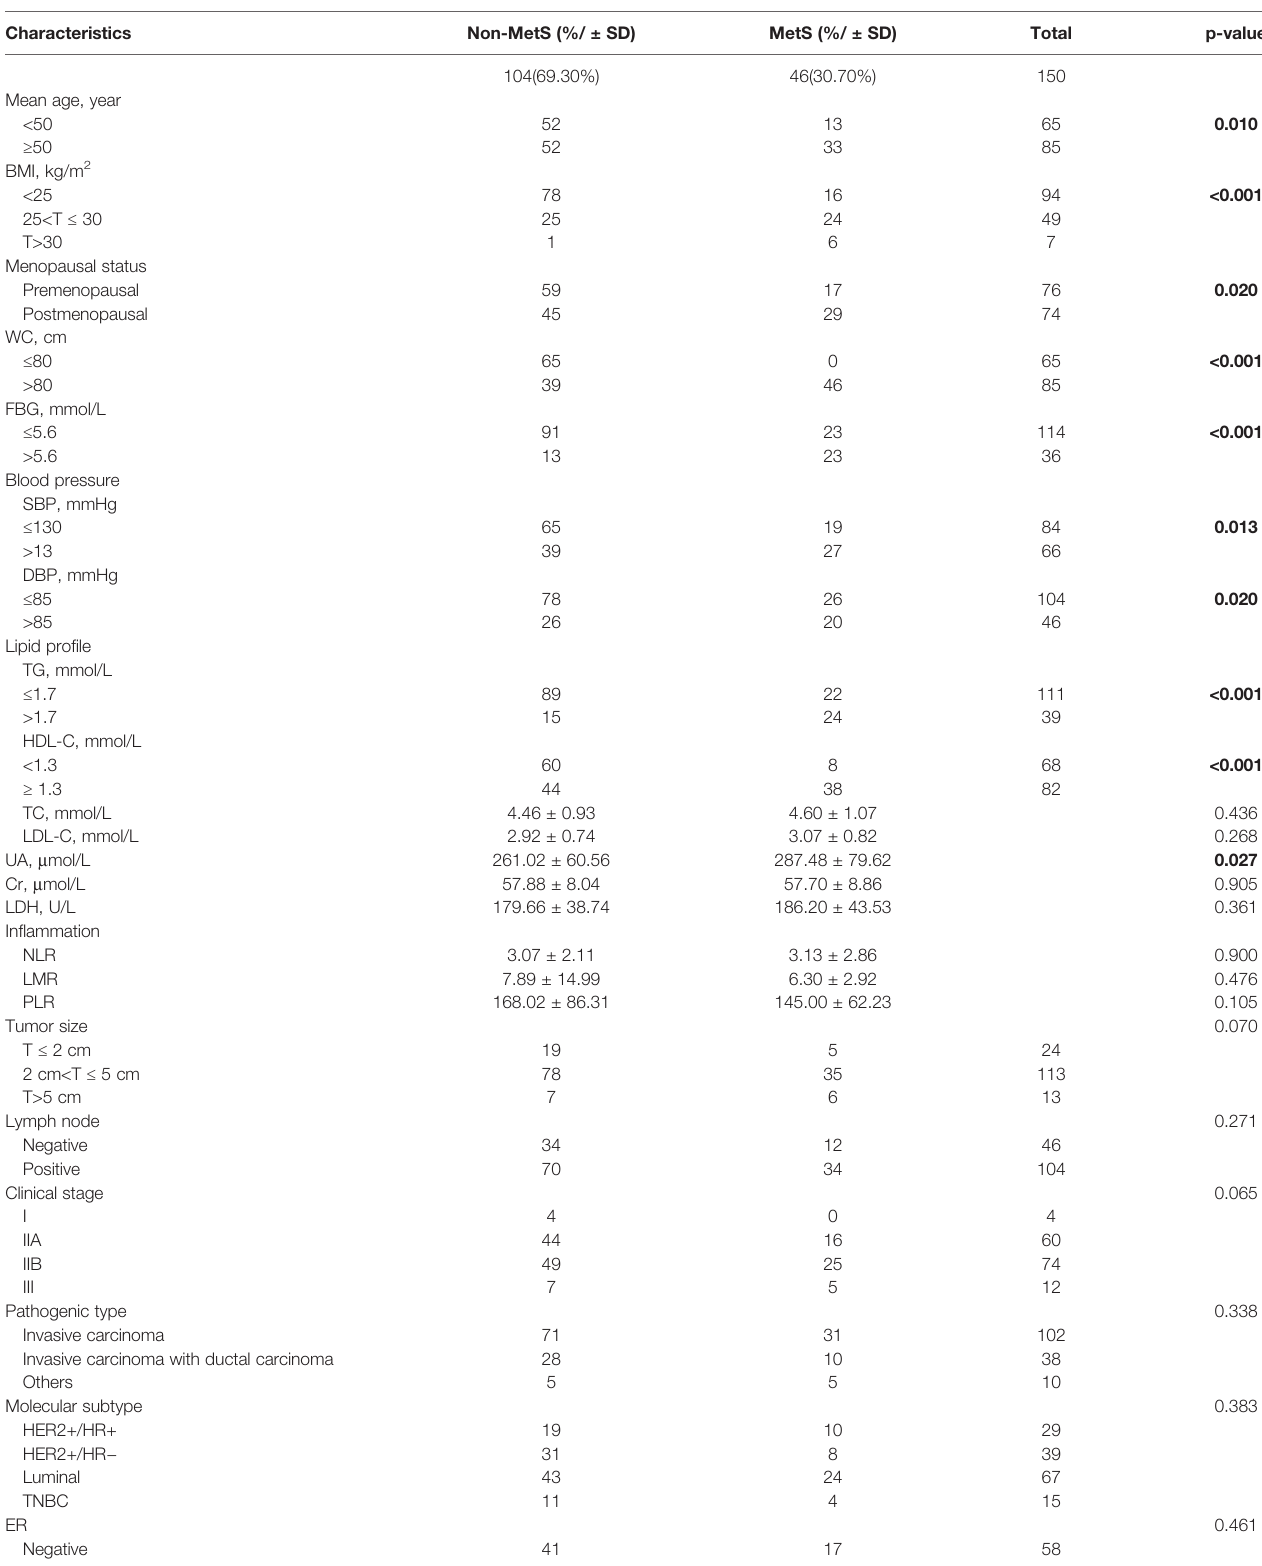
TABLE 1 | Population and clinicopathologic